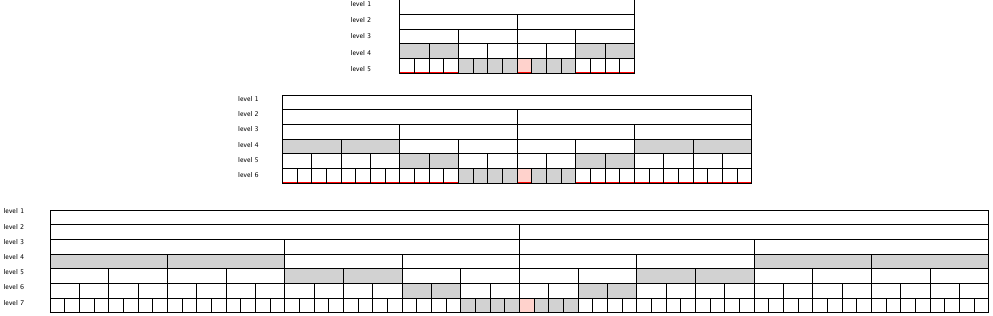
Fig. 2. Schematic construction following the system of Fig. 1b, illustrating scaling as the grid extent increases from 16 to 64cells. Outlined in red is a particular cell of interest. Gray shaded cells are those whose displacements are used to estimate the red cell’s stress in a BH calculation with φ =0.5. As the grid extent doubles, the number of gray cells increases by just 4 cells. The Table 1 summarizes the scaling which is N log N (see text).